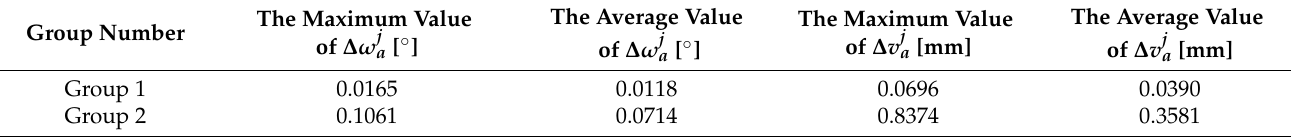
Table 11. Sensitivity analysis results of the average linear comprehensive